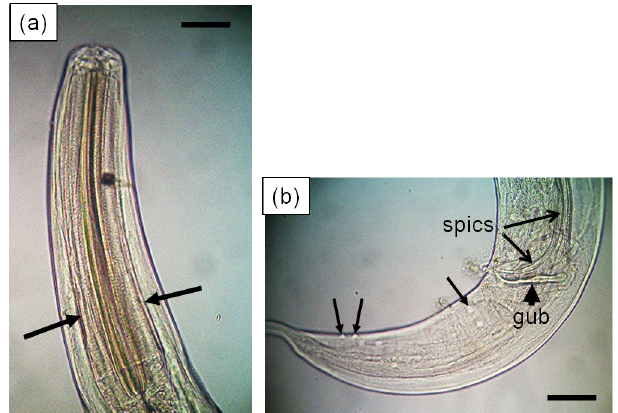
Fig 4. Photomicrographs of a male Atractis sp. nematode detected in a Galápagos giant tortoise faecal sample. Scale bars = 50 μ m. (a) Anterior end of body showing wider sclerotised anterior region of the oesophagus [or pharynx] (arrows). (b) Lateral view of posterior end of male showing caudal papillae (closed arrows), gubernaculum (arrowhead) and distal ends of spicules (open